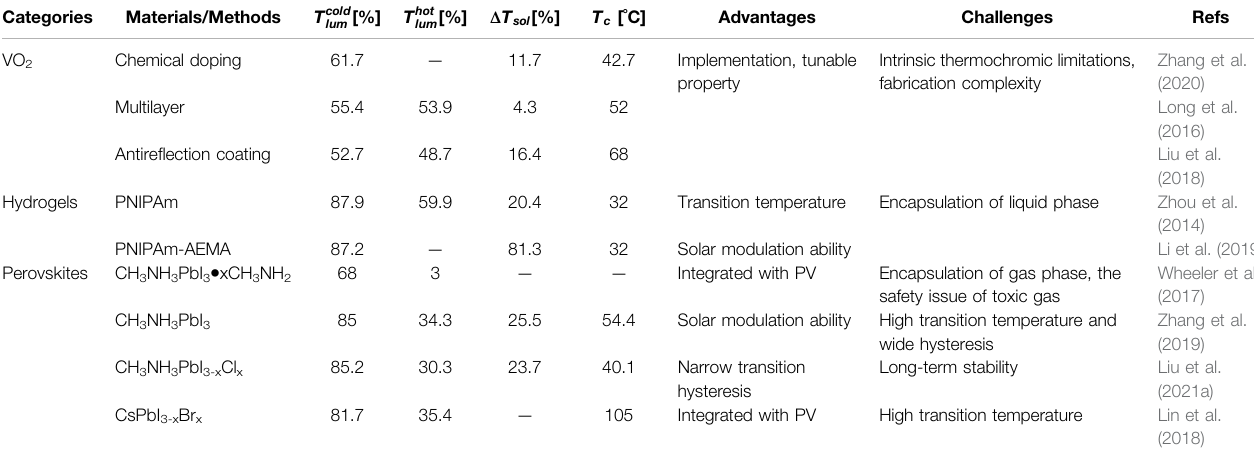
TABLE 1 | Summary of various thermochromic